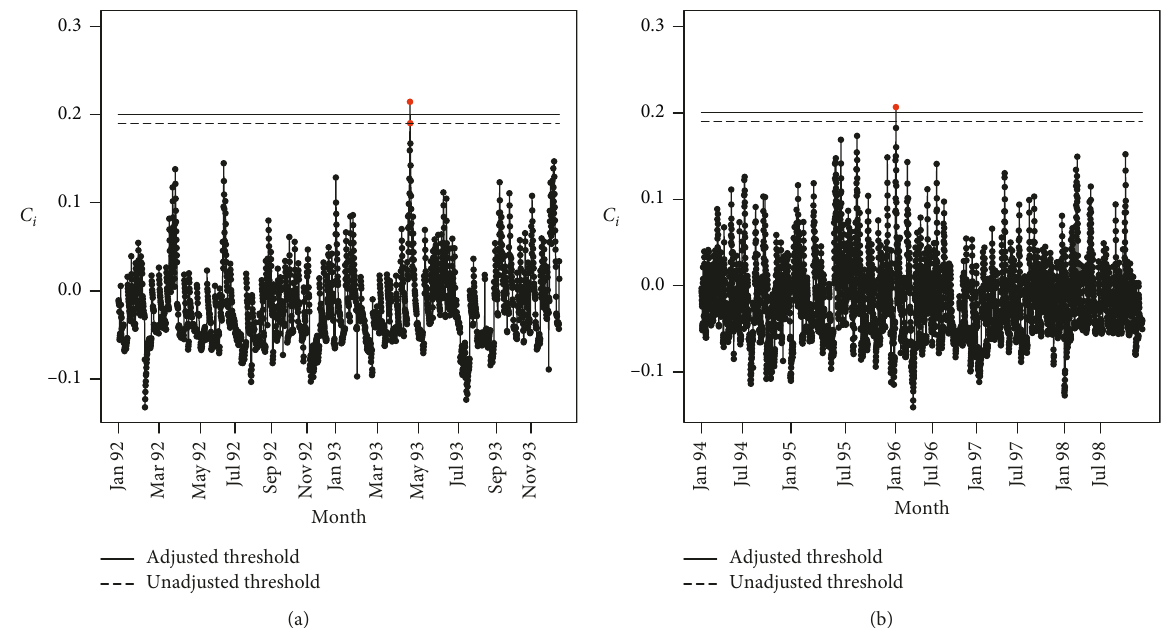
Figure 10: RA-EWMA chart for Phase-I and Phase-II assuming first two years as the Phase-I for 30 days mortality of cardiac surgery patients. (a) Phase-I chart, unadjusted UCL � 0.19 and adjusted UCL � 0.2006. (b) Phase-II chart, unadjusted UCL � 0.19 and adjusted UCL � 0.2006.